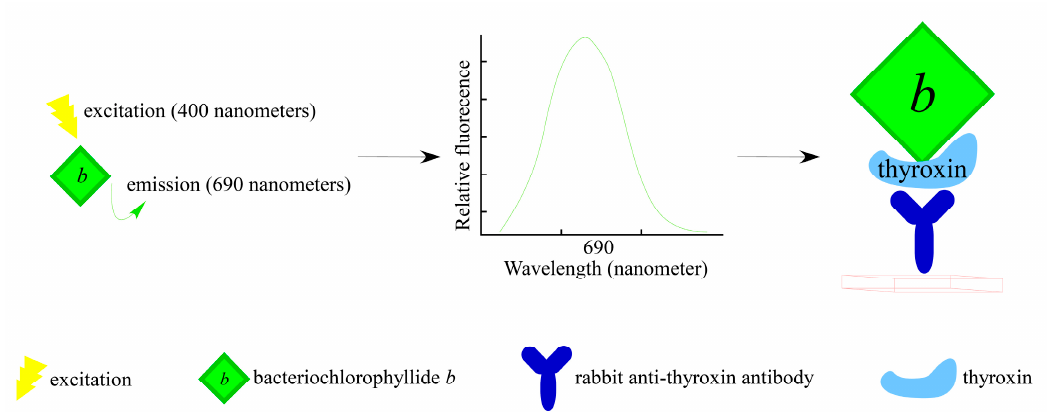
Figure 5. Schematic drawing of bacteriochlorophyllides used as immunosensors (Modified from Mahato et al. [56,58]).